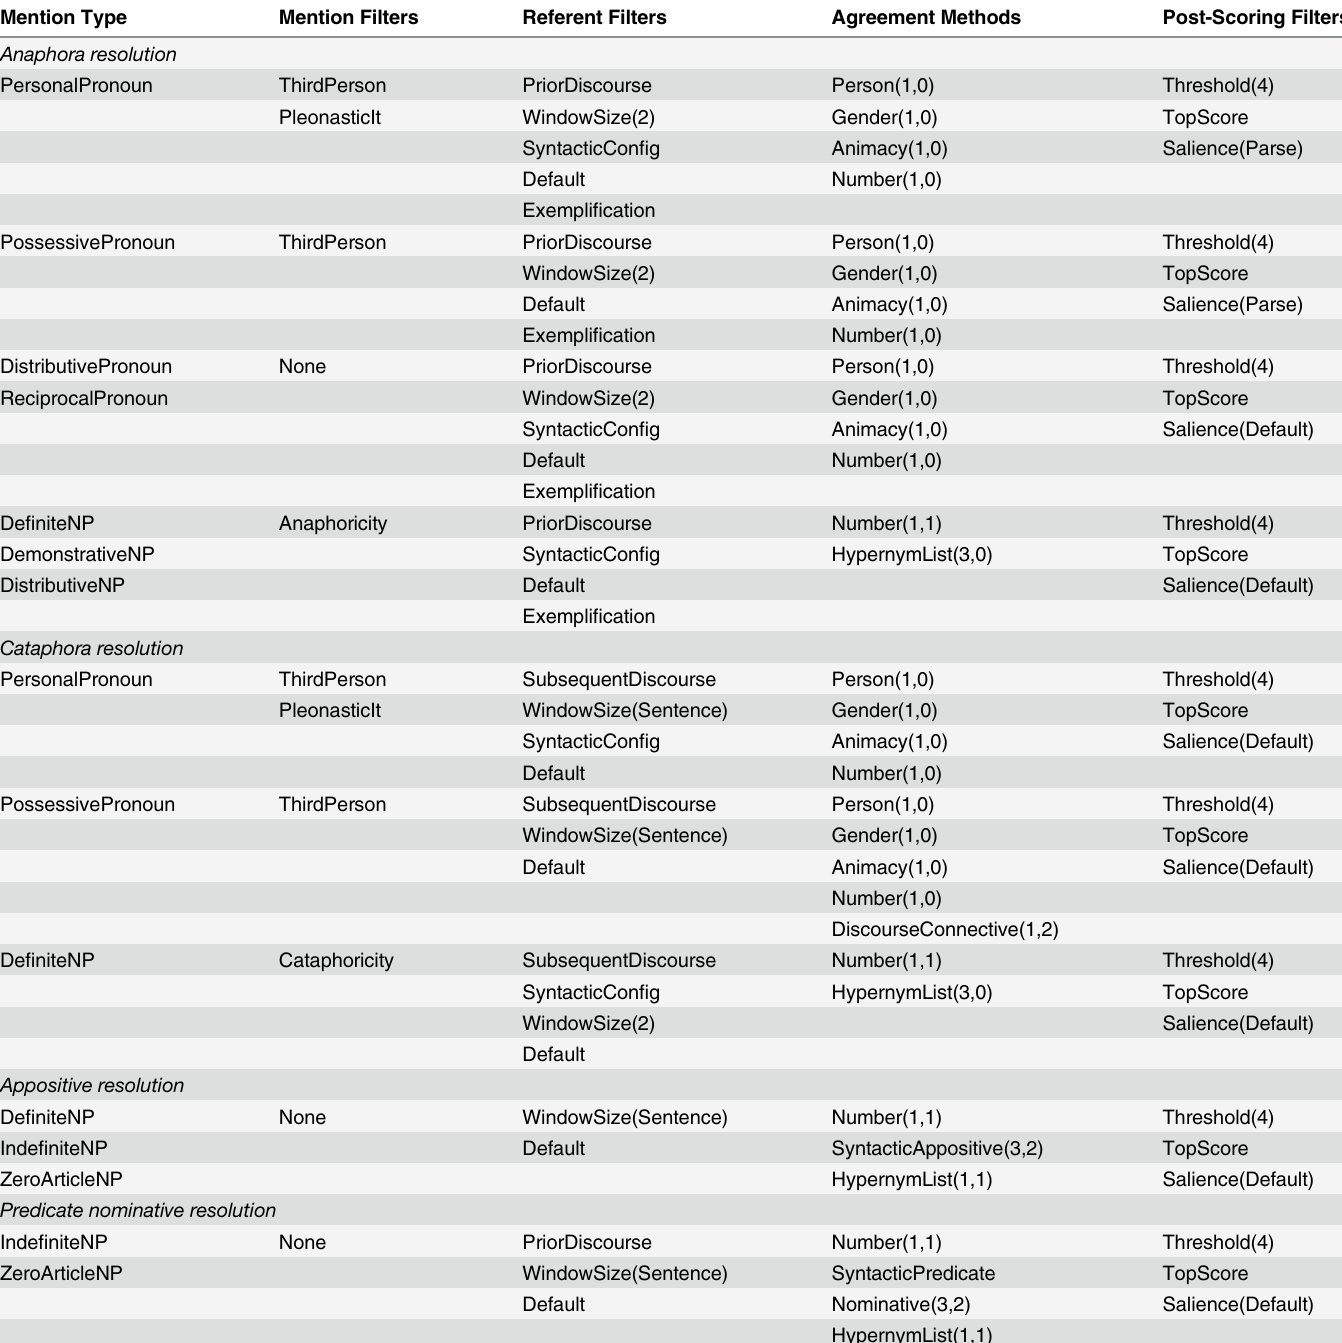
Table 7. Configuration for structured drug label coreference